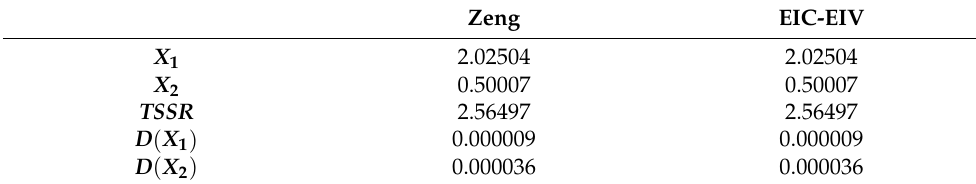
Table 3. Adjustment results of inequality constrained.